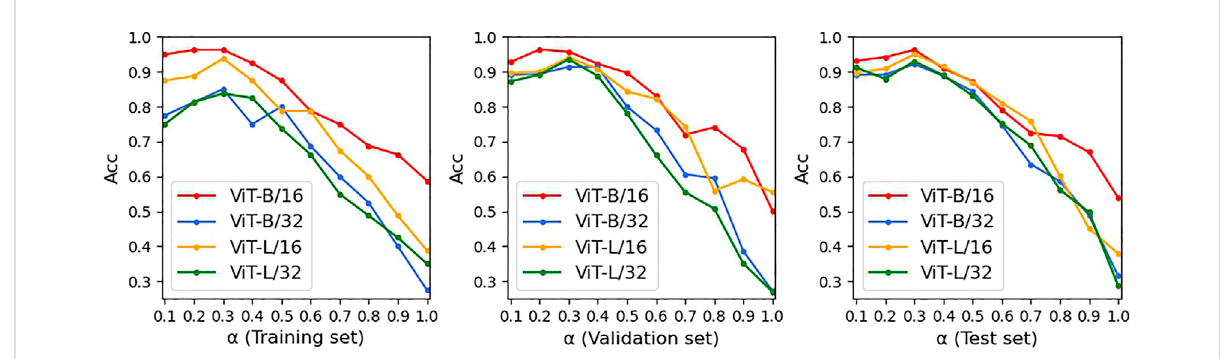
FIGURE 6 ACC score of link prediction on four different ViT structures, where red, blue, orange, and green refer to ViT-B/16, ViT-B/32, ViT-L/16, and ViT- L/32, respectively (set all blocks to six).